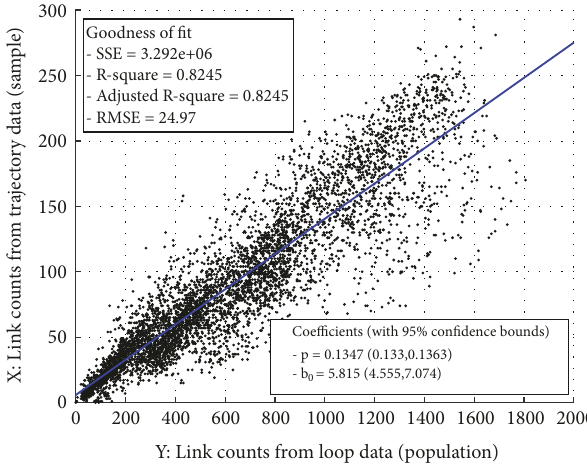
Figure 9: The linear relationship between link counts from trajec- tory data and those from loop